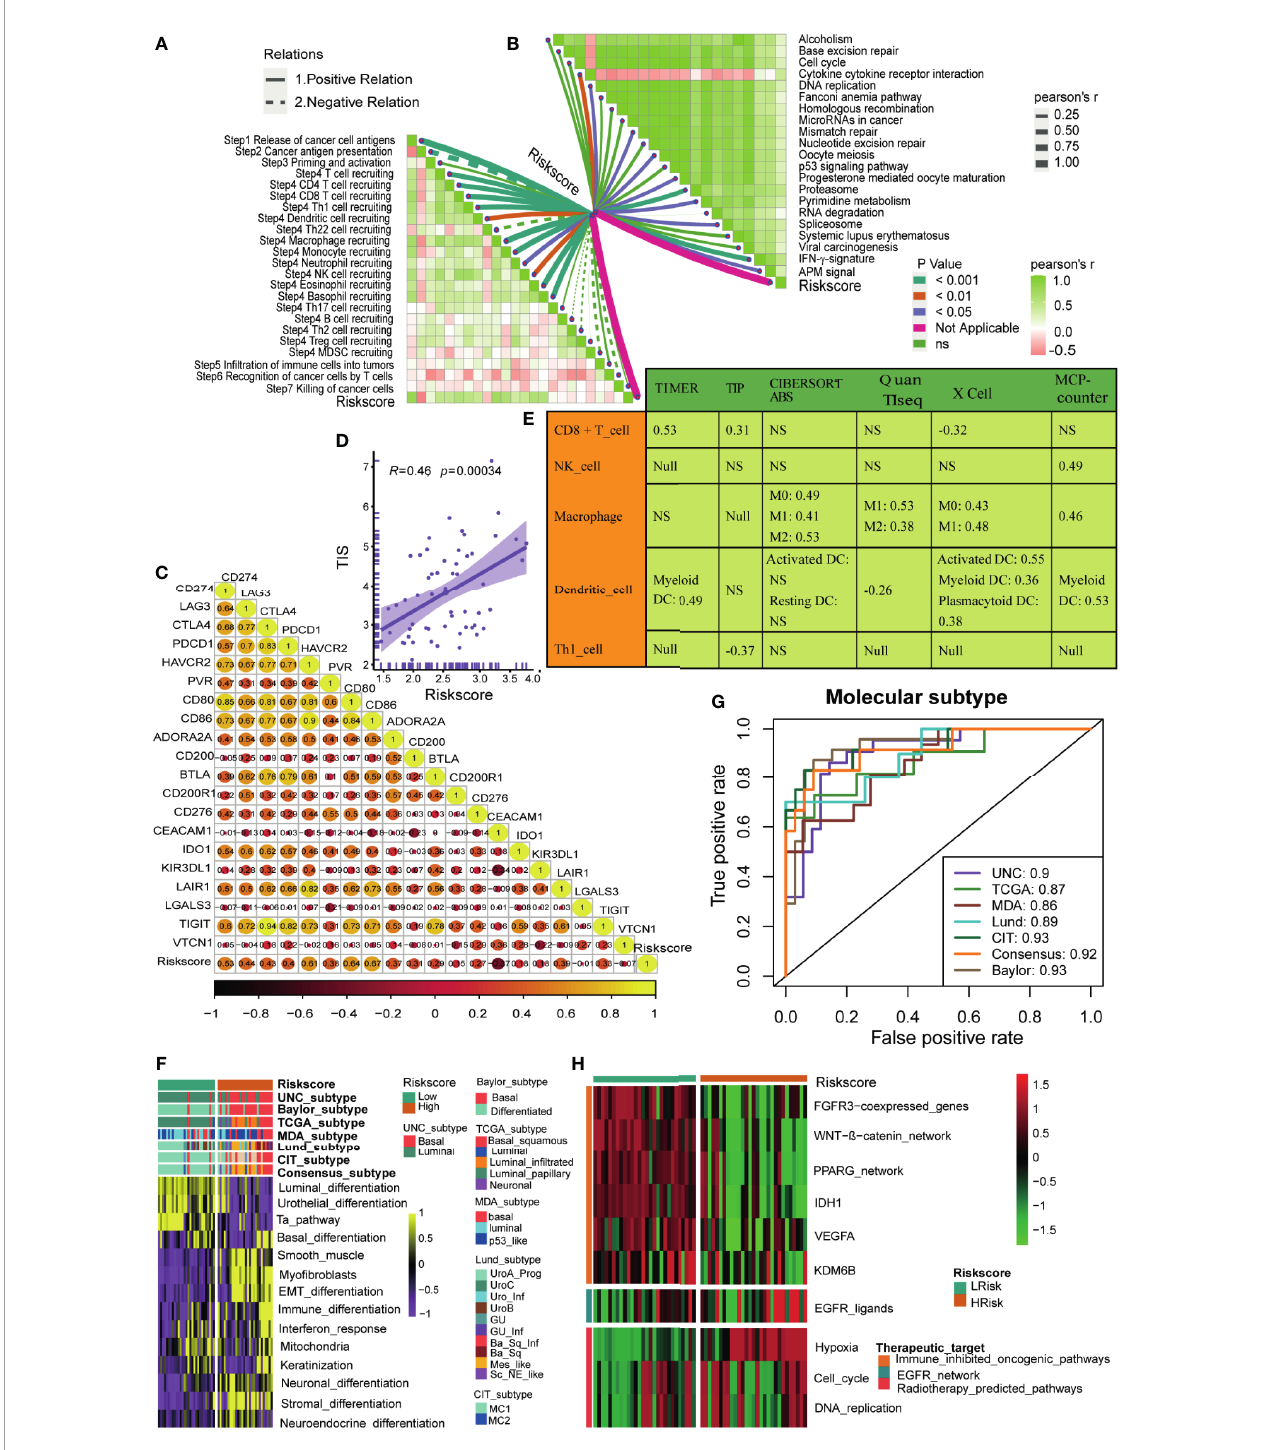
FIGURE 6 | Roles of hypoxia risk score in the Xiangya cohort. (A) Correlations between hypoxia risk score and the activities of the cancer immunity cycles. (B) Correlations between hypoxia risk score and the enrichment scores of immunotherapy-predicted pathways. (C) Correlations between hypoxia risk score and immune checkpoints. (D) Correlations between hypoxia ris score and the T cell in fl amed score (TIS). (E) Correlations between hypoxia risk score and the in fi ltration levels of fi ve tumor in fi ltrating immune cells (CD8+ T cells, NK cells, macrophages, Th1 cells, and dendritic cells). (F) The associations between the hypoxia risk score groups and the molecular subtypes in seven different algorithms. (G) The predictive accuracy of hypoxia risk score for molecular subtypes in seven different algorithms. (H) Correlations between hypoxia risk score and the enrichment scores of several therapeutic signatures such as targeted therapies and